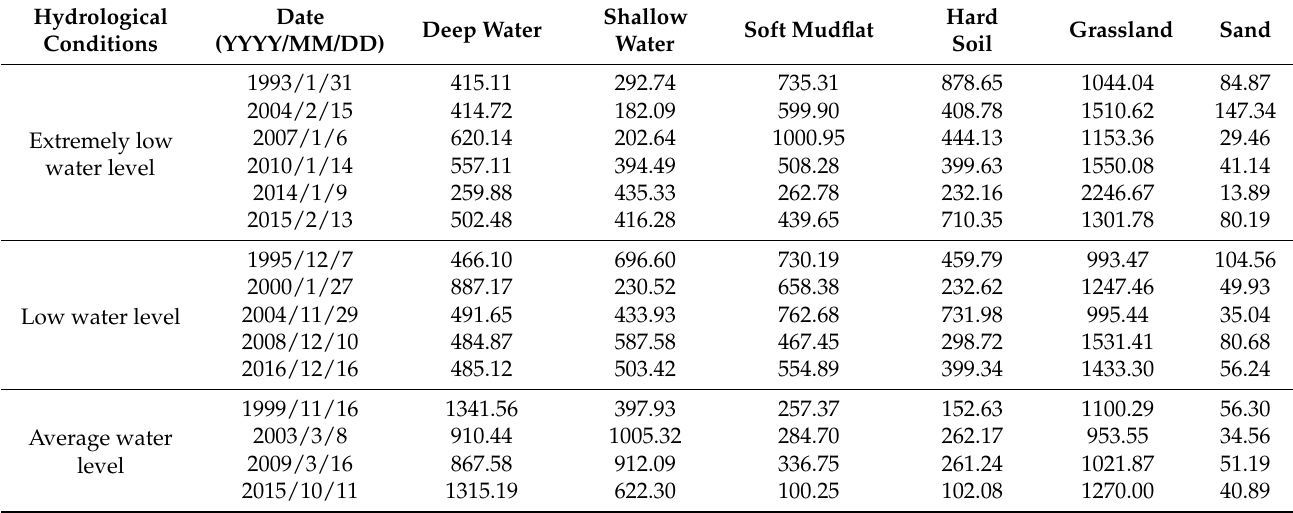
Table 4. Areas of landscape types in the Poyang Lake wetland under various water level conditions (km 2